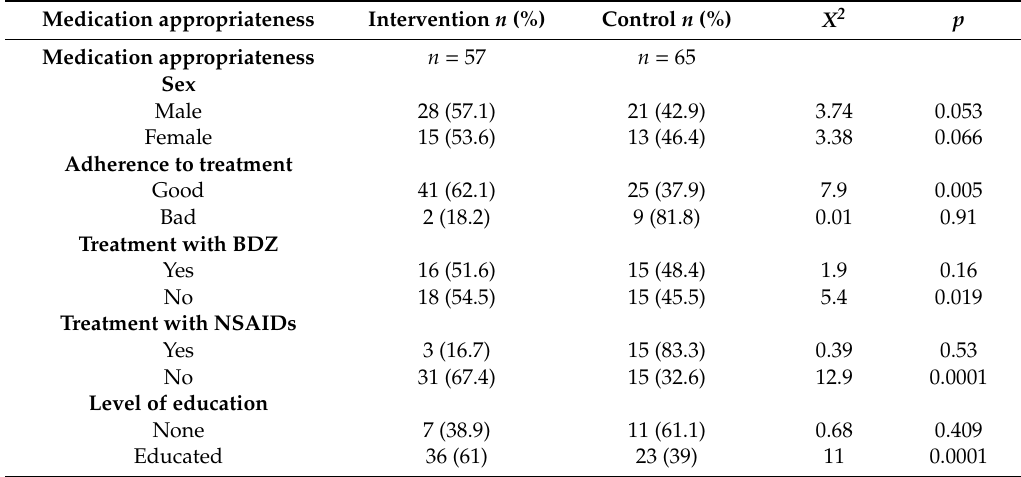
Table 3. E ff ect of shared decision-making on medication appropriateness by subgroups.